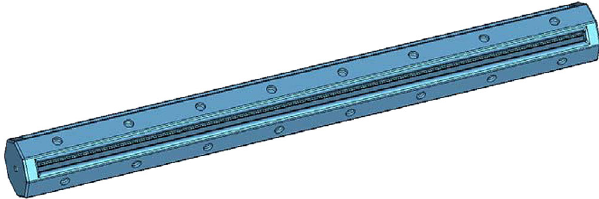
FIG. 7. Full RFQ model showing the location of the tuners.